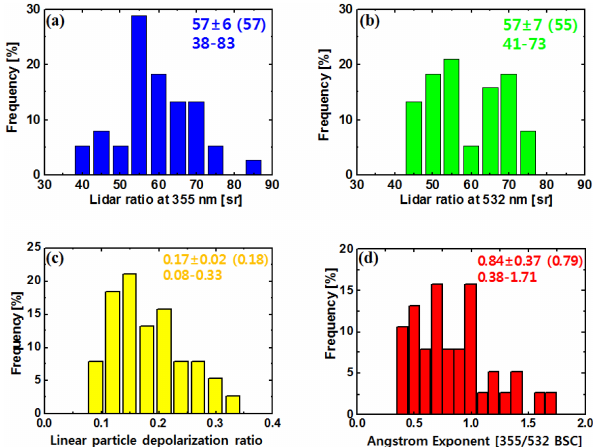
Figure 3. Frequency distributions of optical properties of Asian dust observed between 2009 and 2013. Shown are (a, b) lidar ratios at 355 and 532nm, (c) linear particle depolarization ratios at 532nm, and (d) Ångström exponents for the wavelength pair 355/532nm. The numbers in each plot indicate the mean value and its standard deviation, the median (shown in brackets), and the minimum and maximum value of each